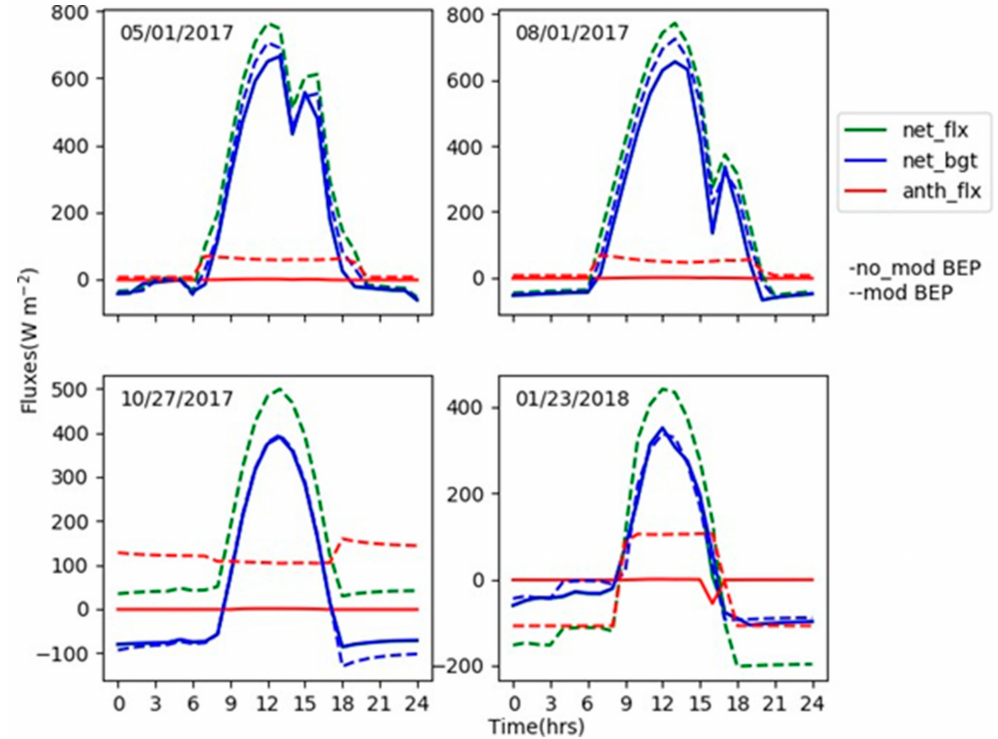
Figure 9. Net heat fluxes (“net_flx”), net radiative energy (“net_bgt”), and anthropogenic flux (“anth_flx” for the original WRF / BEP model (“nomod”) and the modified WRF / BEP model (“ mod”) simulations. Unit is Wm − 2